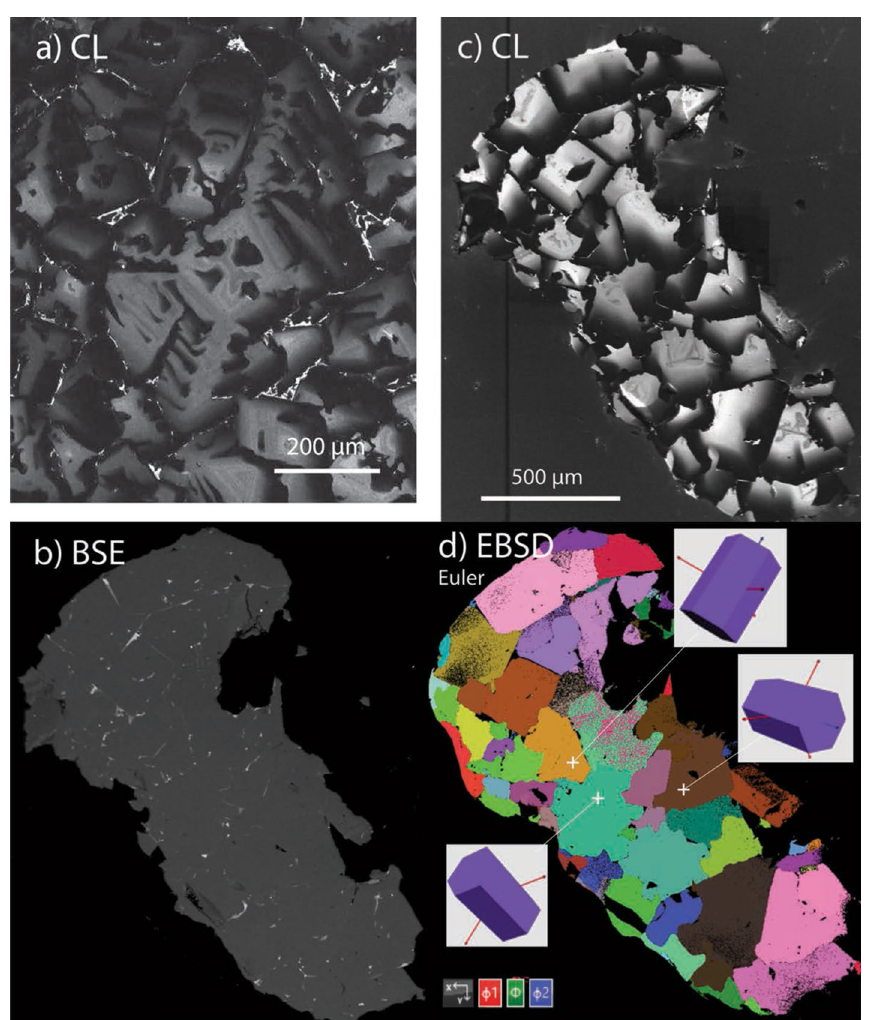
Figure 1. ( a ) CL image of skeletal corundum in the core of a Carmel Sapphire crystal; ( b ) BSE, ( c ) CL and ( d ) EBSD images showing growth of Mt Carmel “non-gem” corundum (Carmel Sapphire). Note skeletal structures in the bright cores of most crystals, surrounded by smoother zoning. Prisms in ( c , d ) show the orientation of single crystals or of most crystals in small aggregates that make up the larger